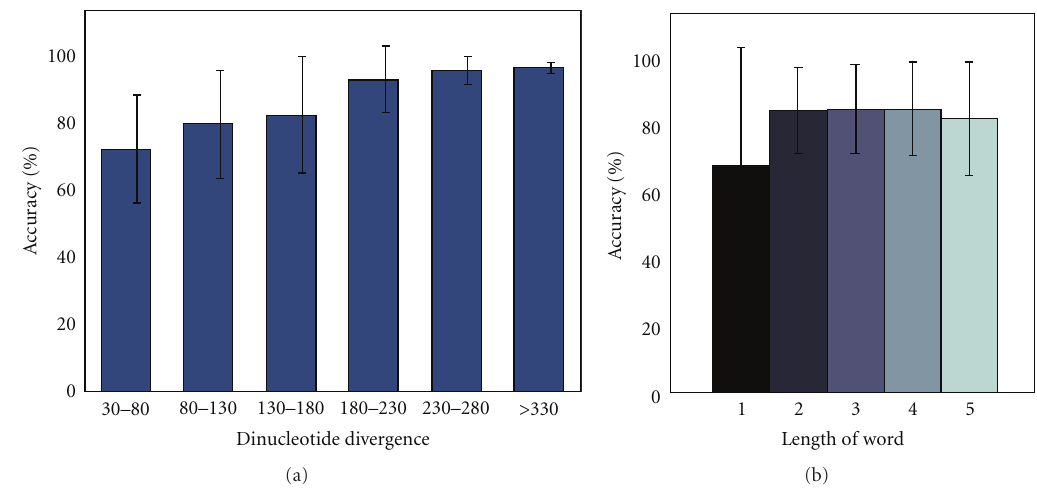
Figure 3: Performance of Poisson Mixture Model at (a) di ff erent coverage ratios in a 2-species datasets. Datasets with low δ ∗ values (100– 150) were chosen (b) di ff erent reads lengths (50–1000